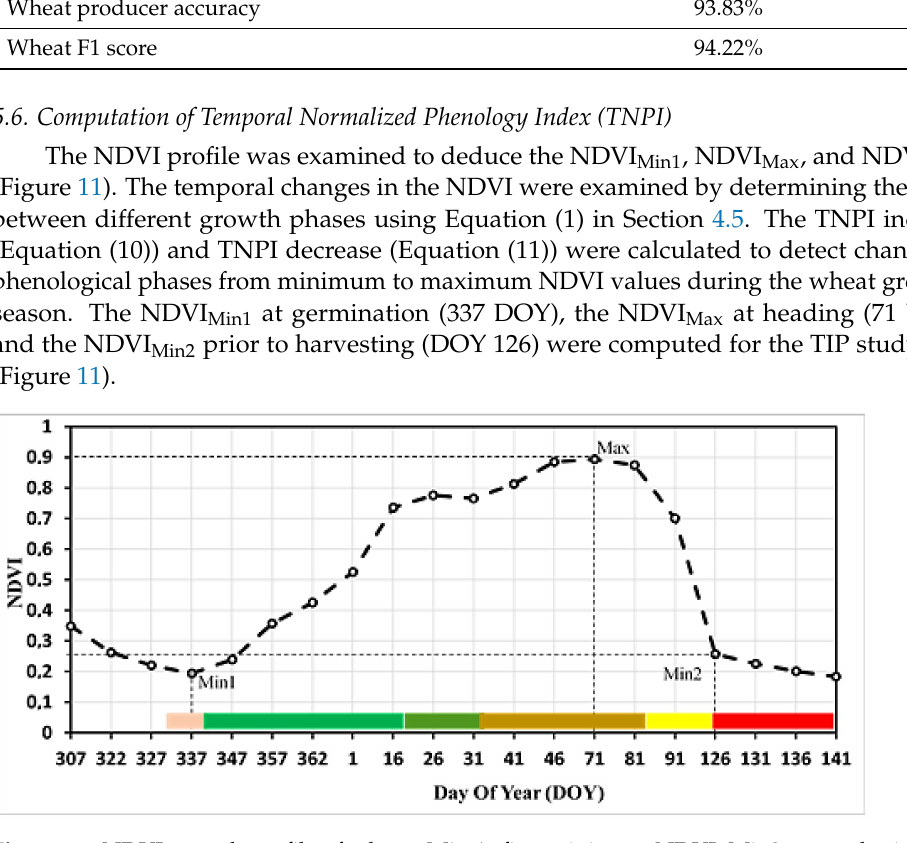
Figure 11. NDVI growth profile of wheat. Min 1: first minimum NDVI, Min2: second minimum NDVI, and Max: maximum